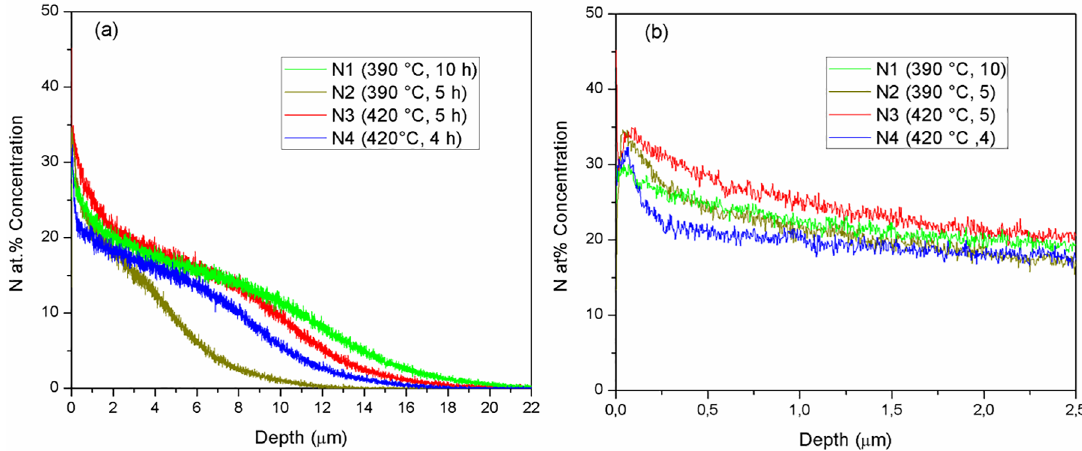
Figure 3. GDOES Nitrogen profiles of nitrided samples (a) until a depth of 22 μm (b) closer to the surface, until a depth of 2.5